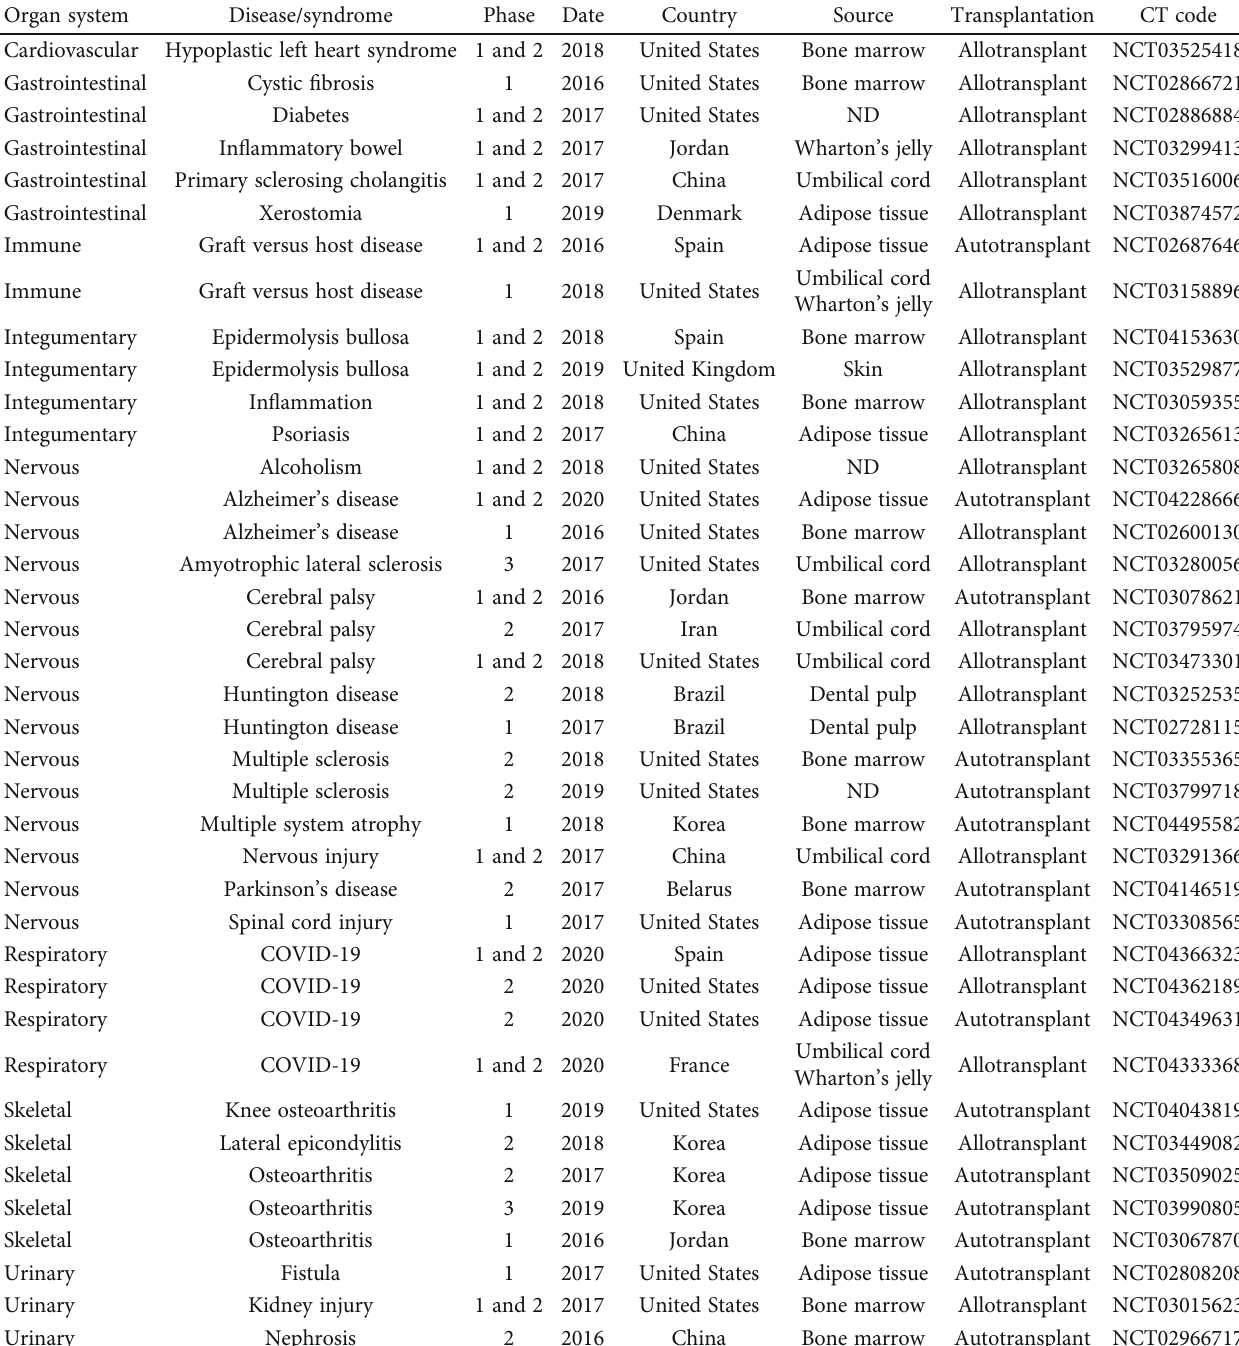
Table 2: Active clinical trials on mesenchymal stromal/stem cell-based therapy started during 2016-2020 (U. S. National Library of